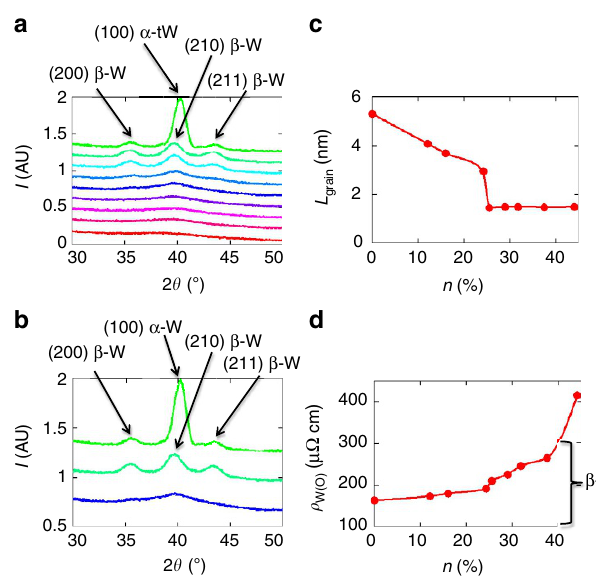
Figure 4 | Materials’ characterization. The colour schemes used here for n , indicating the oxygen concentration, are the same as in Figs 2 and 3. ( a ) X-ray diffraction for W(O) films with different n . The crystallographic orientation and the corresponding phase ( a or b ) are indicated by arrows. ( b ) Detailed X-ray diffraction on films with three noteworthy oxygen concentrations: pure W, n ¼ 12.1% and n ¼ 25.5%. There is a small shift in the peak at 2 y ¼ 40 (cid:2) from n ¼ 0% to n ¼ 12.1%, indicating a larger amount of b (cid:3) W for n ¼ 12.1%. ( c ) Grain size L Grain versus n . ( d ) Resistivity versus n . b (cid:3) W has a resistivity between 100 and 300 mO cm as indicated by the